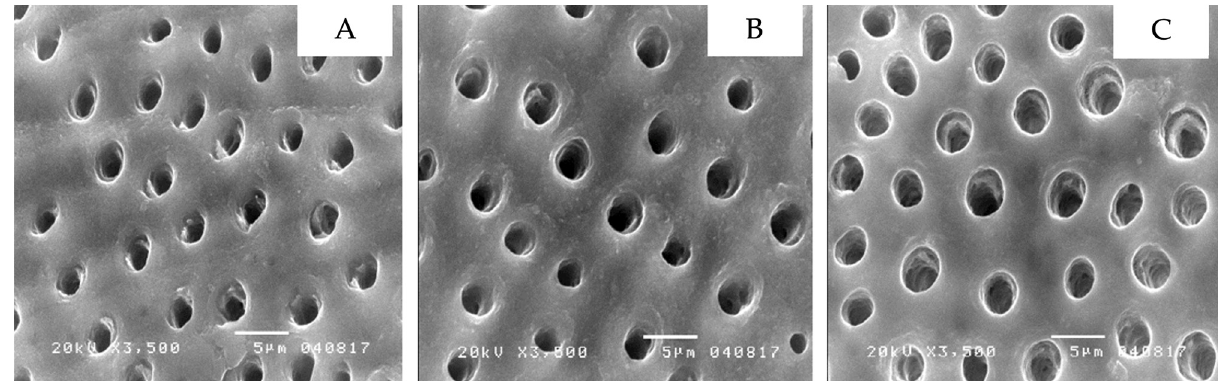
Figure 3. The dentin micro-morphology with 37.5 percent phosphoric acid applied to demonstrate an absence of a smear layer or smear plug, widely opened dentinal tubules, and a presence of silica particles as shown in the image: non-contaminated dentin ( A ), dentin contaminated with topical anesthetic solution ( B ), dentin contaminated with topical anesthetic gel ( C ).